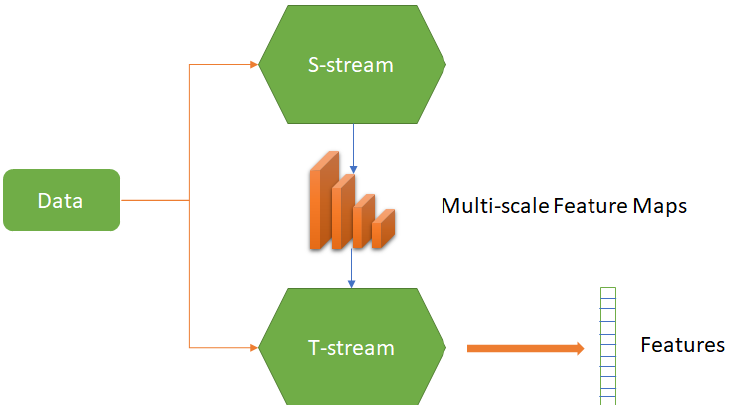
Figure 15. Parallel-Structure-Based Transfer learning method based on